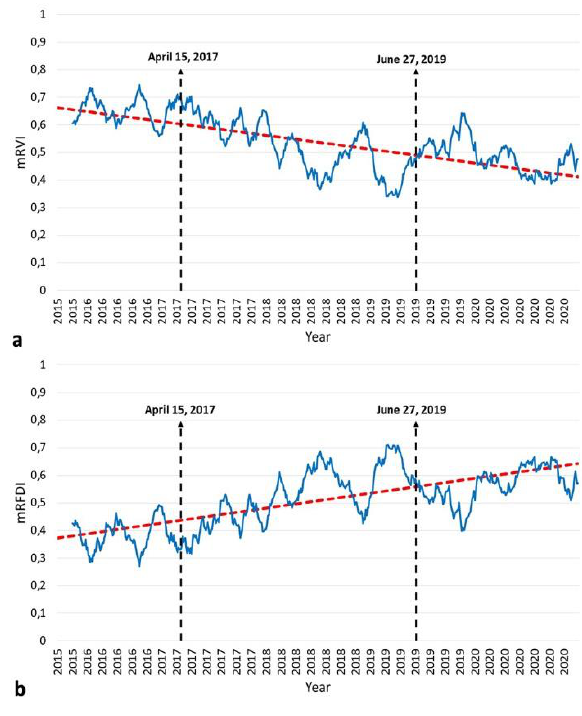
Figure 7. Sentinel-1 2015-2020 GEE a) mRVI and b) mRFDI time